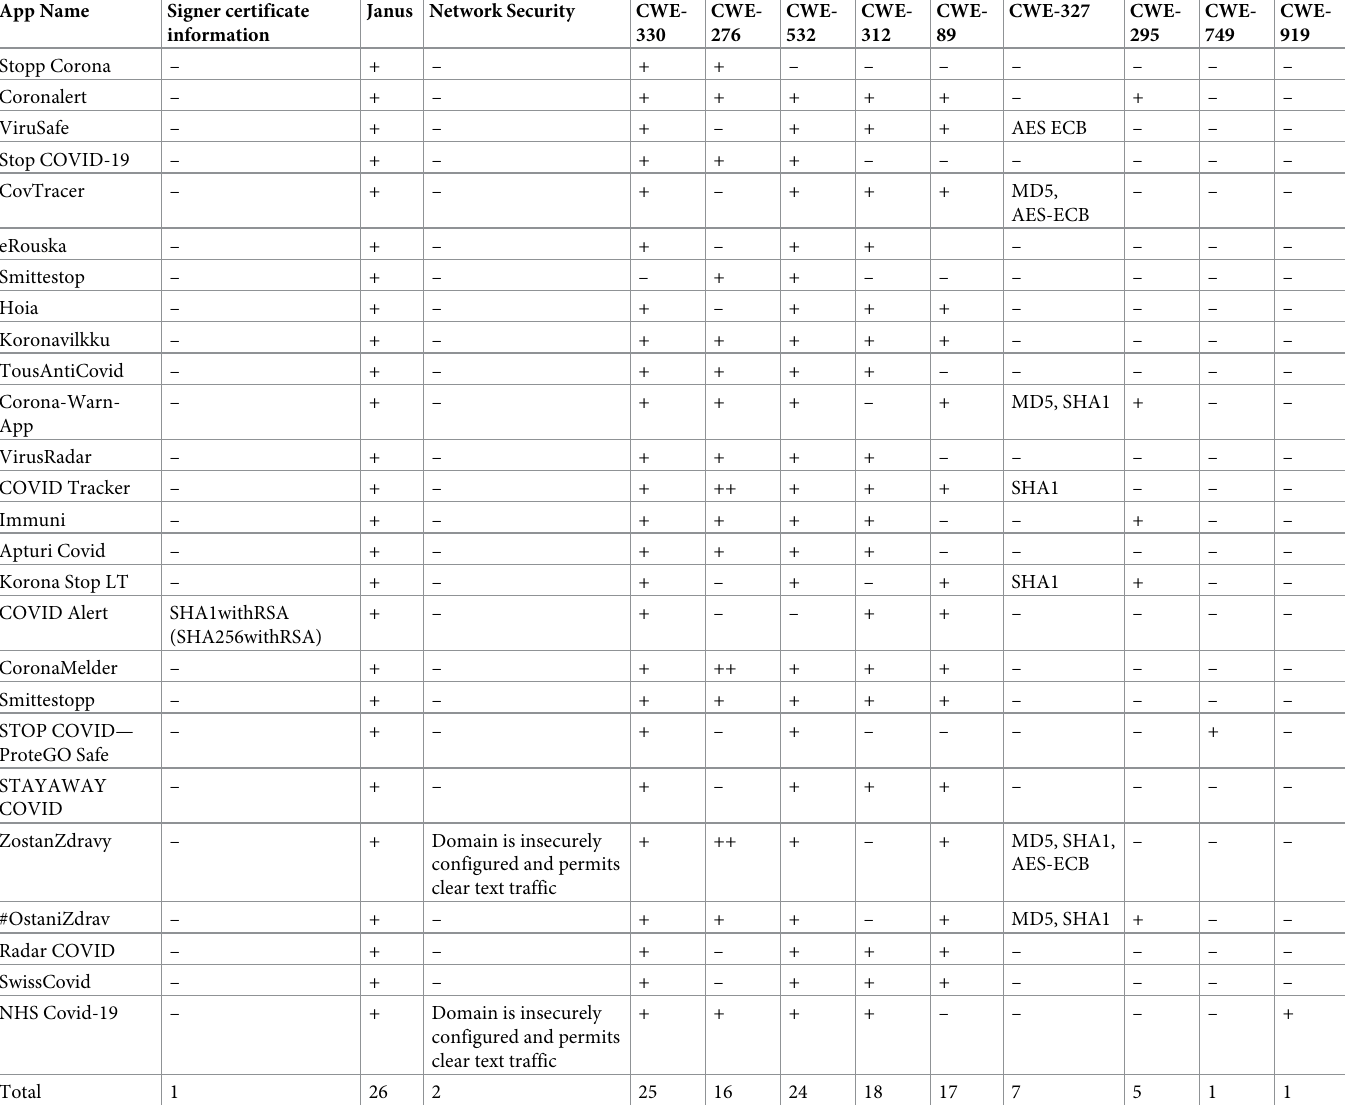
Table 6. Potential weaknesses and other security issues per